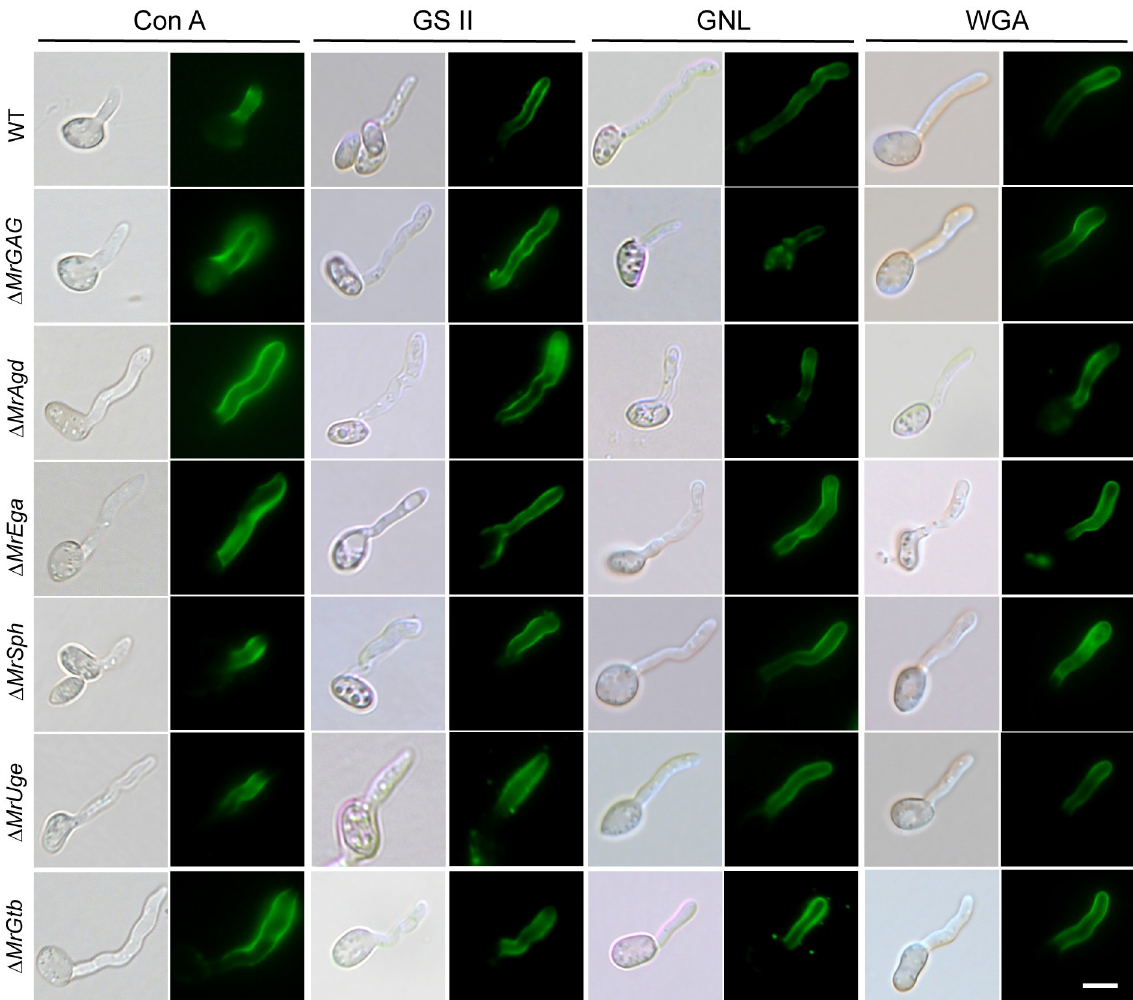
Fig 3. Lectin staining of the WT and mutant germlings for different cell wall constituents. The WT and mutant spores were germinated in SDB and then stained with different fluorescent lectins: ConA, Concanavalin A for detecting α -mannopyranosyl and α -glucopyranosyl residues; GSII for detecting α - or β -linked N -acetyl- D -glucosamine); GNL, Galanthus nivalis lectin for detecting α -1,3-mannose; WGA, wheat germ agglutinin for selective binding N -acetyl- D -glucosamine and N -acetylneuraminic acid residues.